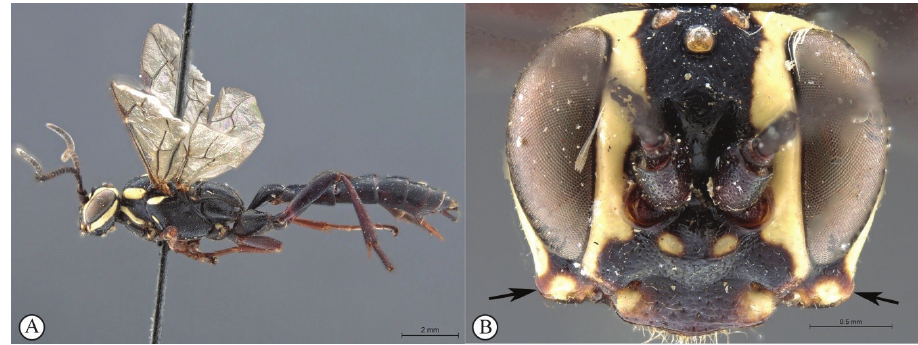
General coloration black (A); lower gena expanded into a backward curved